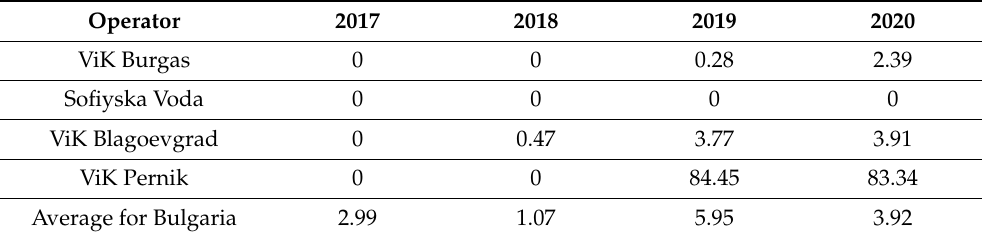
Table 2. Percent of population (%) with water supply regime due to water shortage.